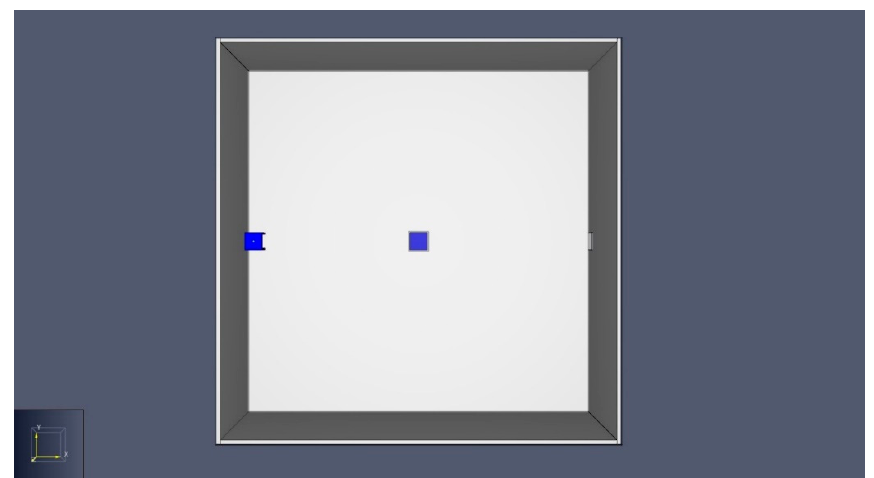
Figure 2. The top view of the analyzed building. Two blue squares represent the emission